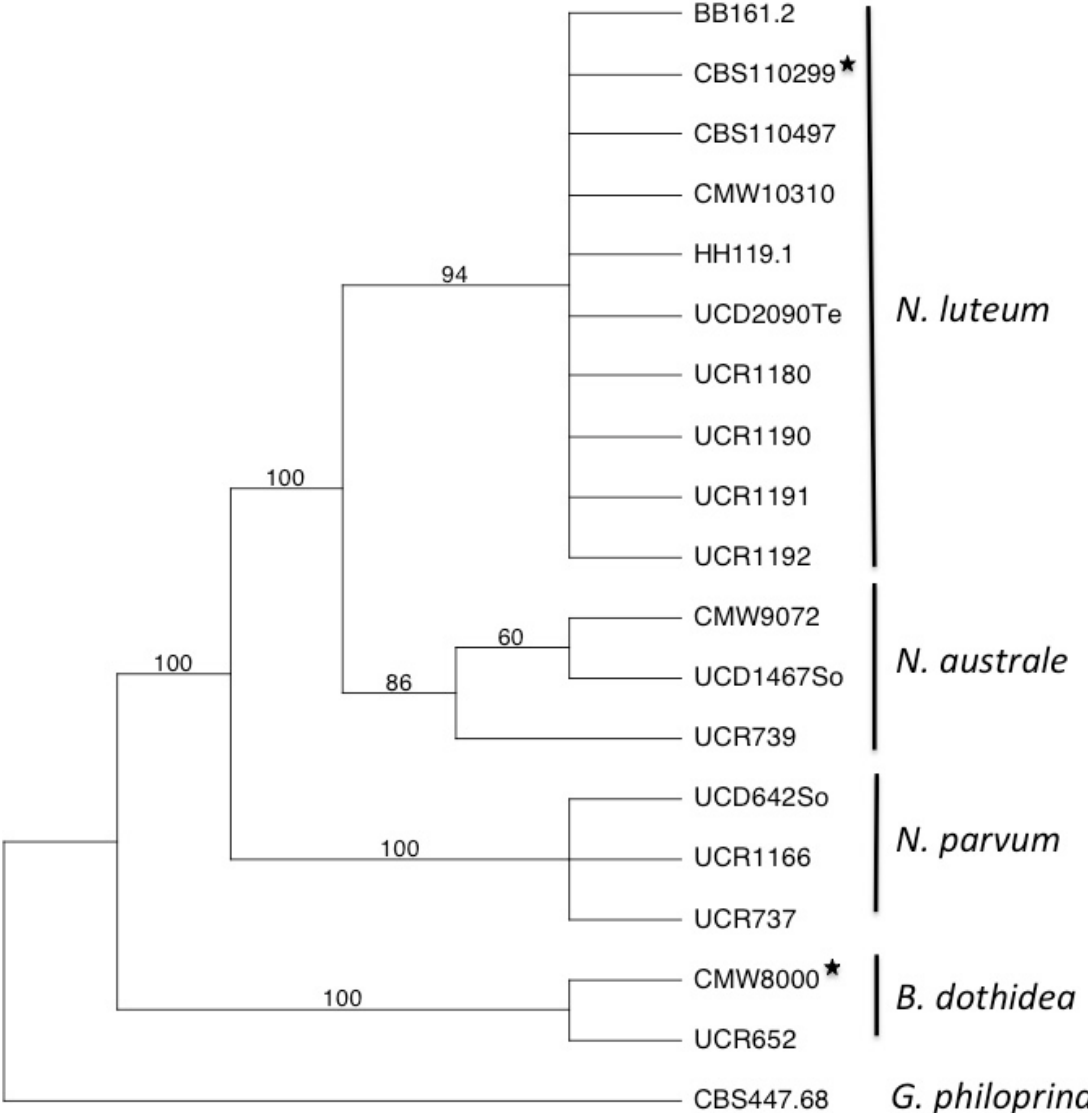
Figure 3. Consensus tree obtained from combined ITS and b-tubulin sequence data sets. (TL=279 steps, CI= 0.964158, RI= 0.943820, RC= 0.909992). Bootstrap support values from 1000 replicates higher than 50% are reported at the nodes. (*) ex- type sequences from